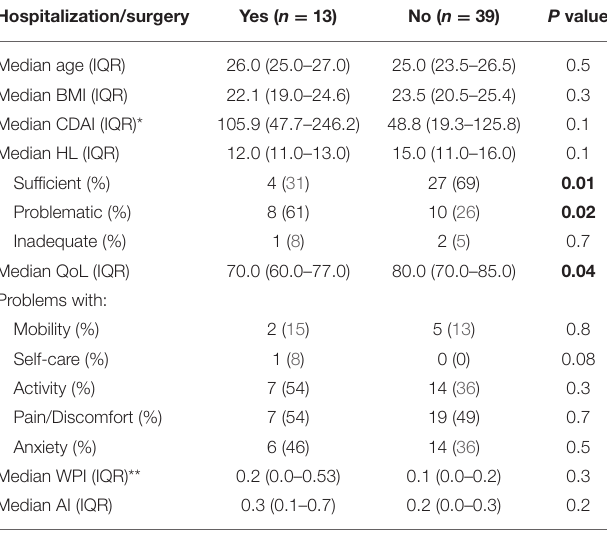
TABLE 4 | Comparison between CD patients with and without hospitalization/surgery. Hospitalization/surgery